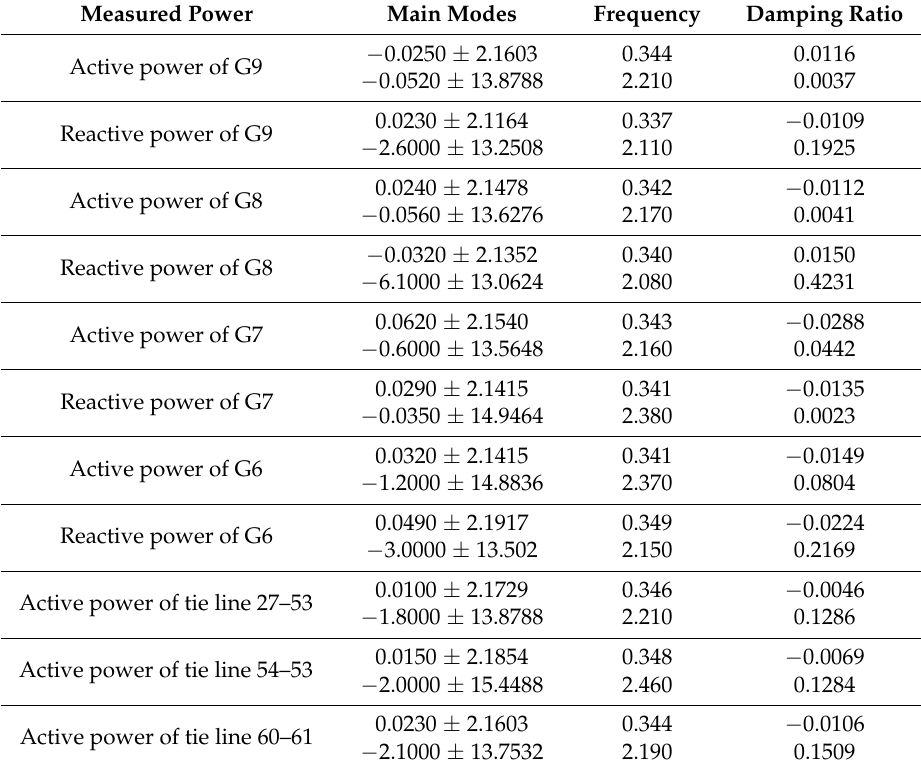
Table 6. Results of Prony analysis under the case with the penetration level